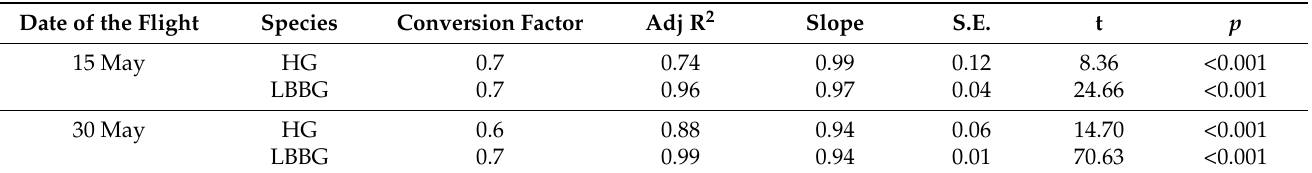
Table 1. Results of the different linear models fitted for the best conversion factors on both flights (15 and 30 May). Best models are considered the ones with best fitted Ajd R 2 and slopes closer to 1.